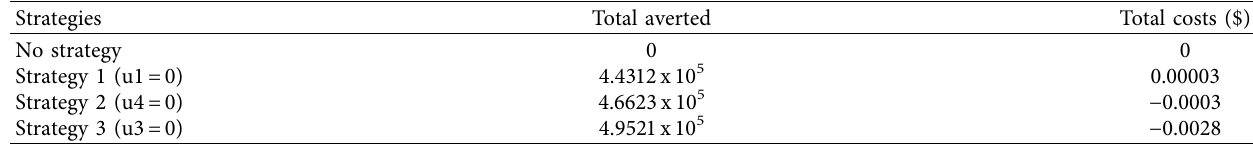
Table 4: Rank of strategies based on the number of the infection averted.